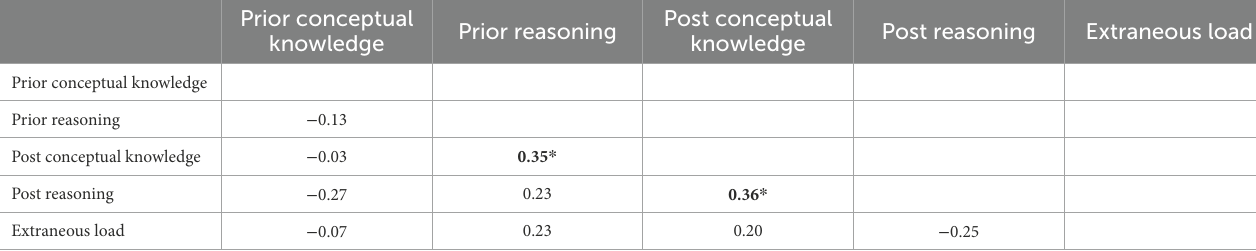
TABLE 5 Intercorrelations of relevant variables in Study